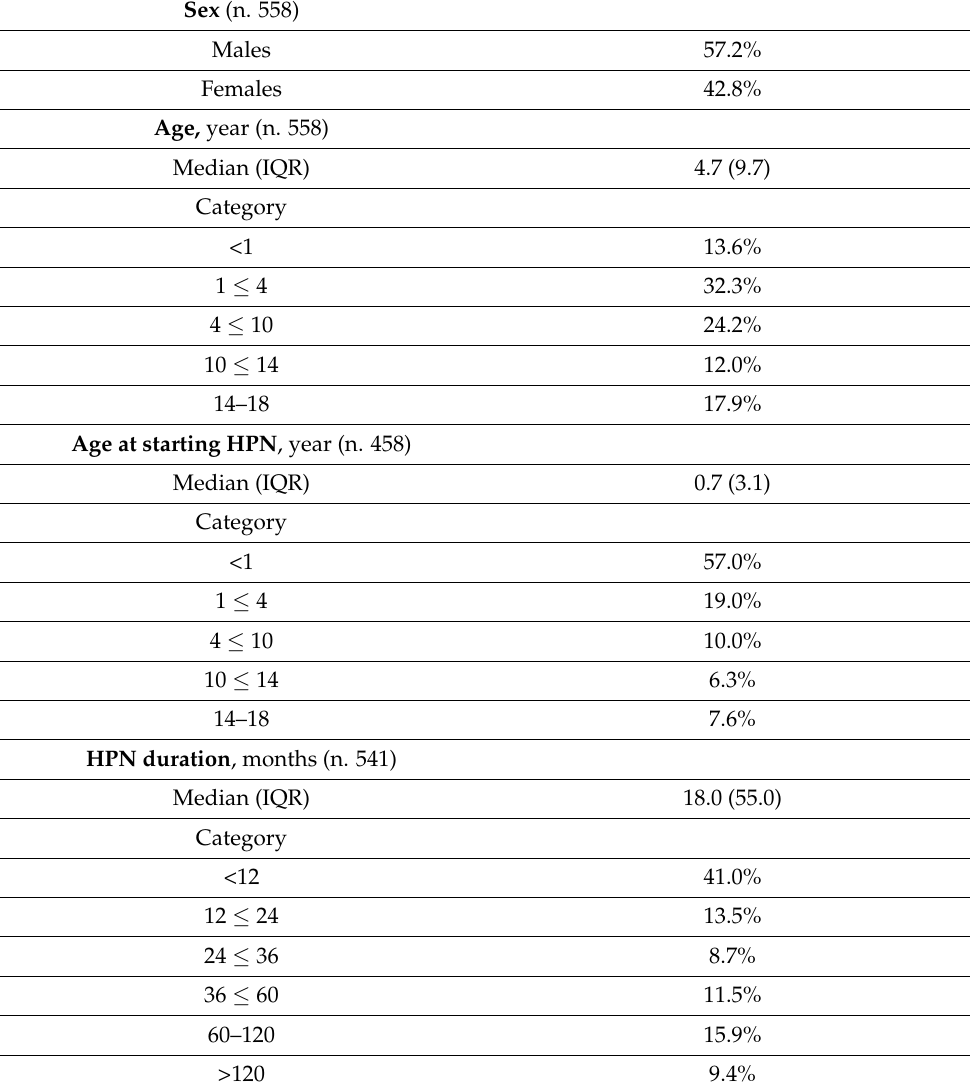
Table 1. Patient characteristics and clinical